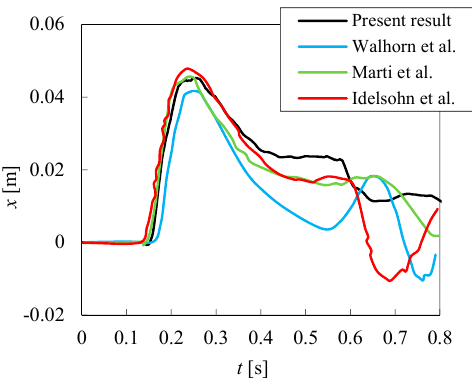
Figure 6. Comparison of computed time history of the horizontal displacement at the top of the